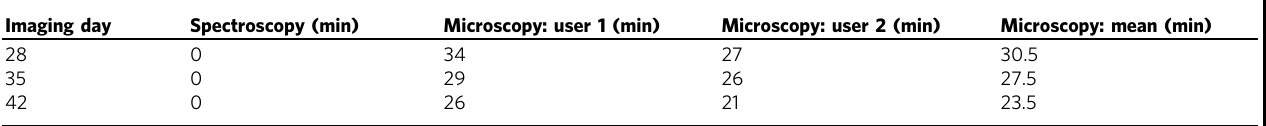
All spectroscopy values are zero because the data acquisition software (LabVIEW) corrects for laser power and acquisition time, subtracts background fl uorescence, and calculates each ratio automaticallyat the end of eachscan.After acquisitionof microscopyimages,quantitationof fl uorescence requires manualdrawing of regionsof interest (ROIs),exportof the datafrom each imageinto a comma separated values (CSV) fi le, correction for exposure time, subtraction of background fl uorescence, and calculation of DsRed/GFP fl uorescence ratio (see Supplementary Fig. 3). Values in minutes for two separate users, and the mean of the two, are shown for the images obtained on Days 28, 35, and 42.